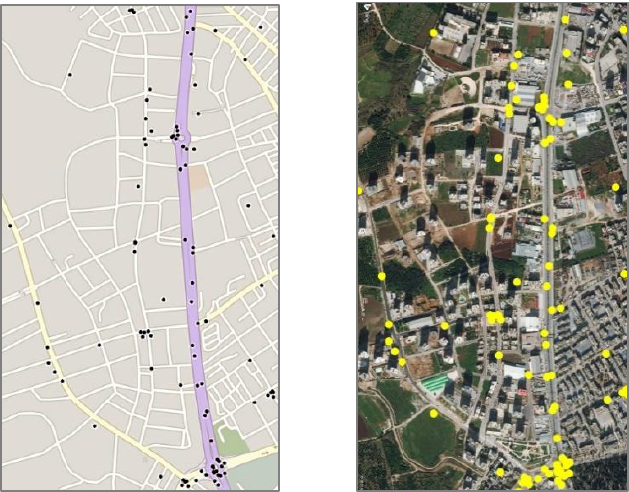
Figure 6 Street Network and Location of Accidents in H.O.Merzeci